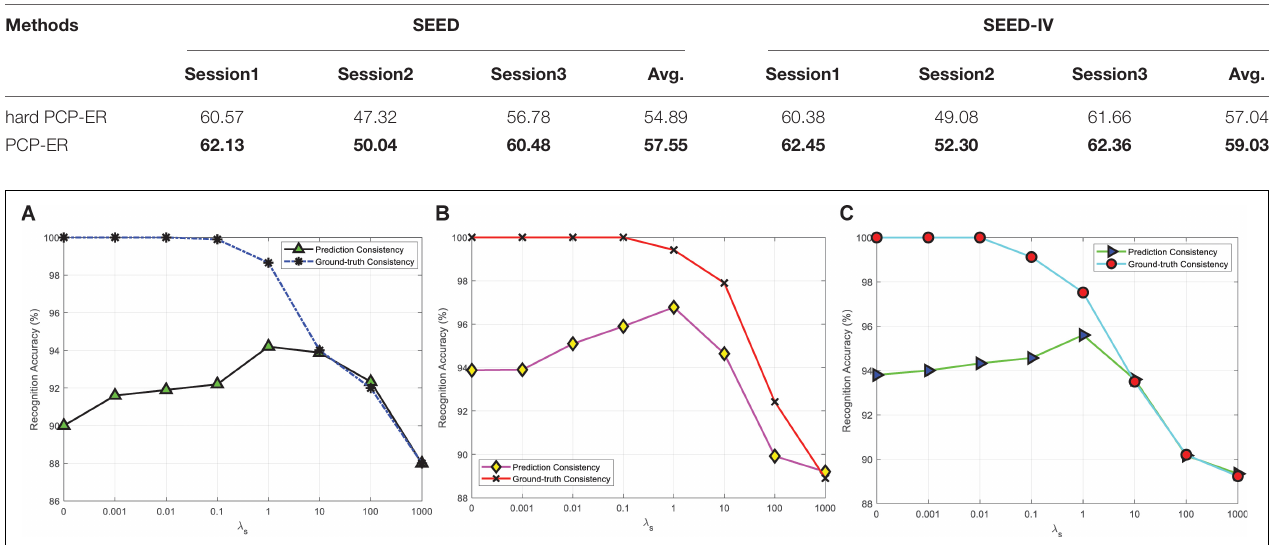
FIGURE 4 | Prediction consistency and ground-truth consistency between f ( x ) and w ( x ) with different λ s values on (A) DEAP; (B) SEED; and (C)